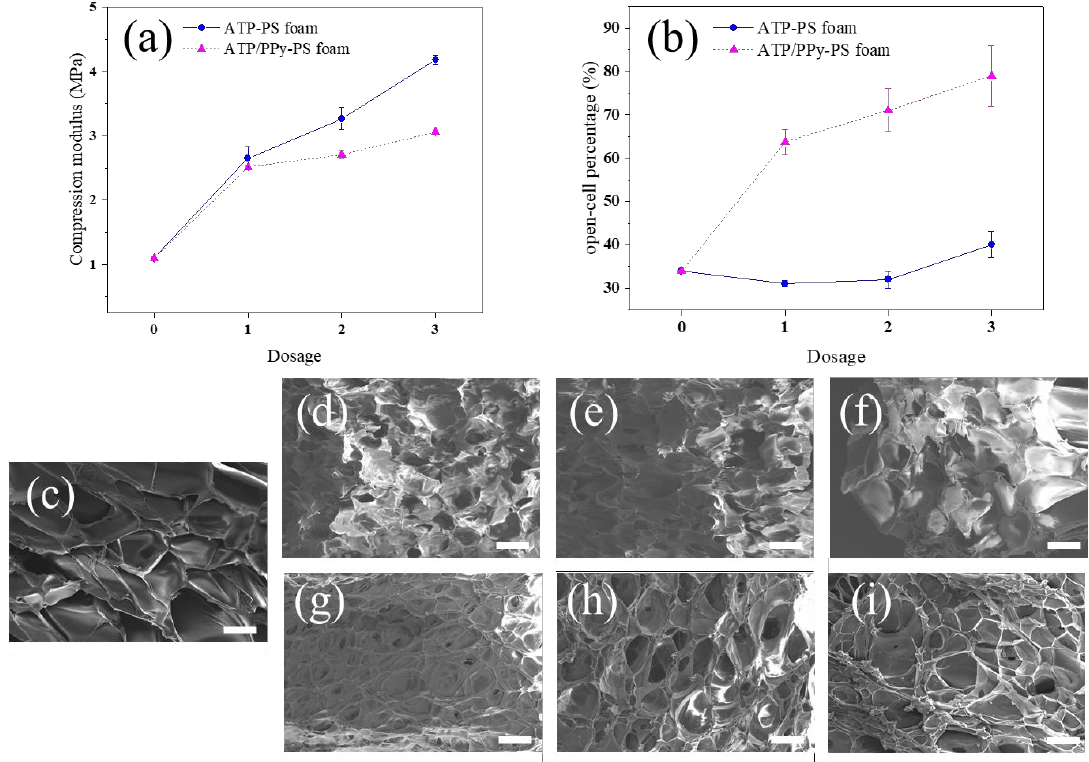
Figure 6. ( a ) The compression modulus measurements of neat PS foam, ATP-PS foams, and ATP / PPy-PS foams, according to the ASTM D1621-16 standard. ( b ) Corresponding open-cell percentage of all foams, with respective top view SEM images of ( c ) neat PS foam, ( d – f ) ATP-PS 1, 2, 3 and ( g – i ) ATP / PPy-PS 1, 2, 3, scale bar: 2 μm.